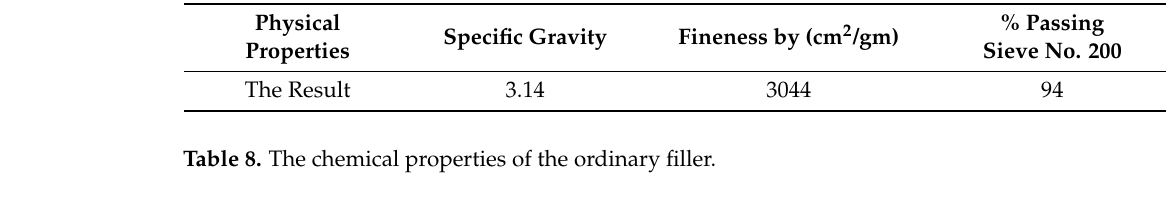
Table 7. The Physical properties of the ordinary filler.